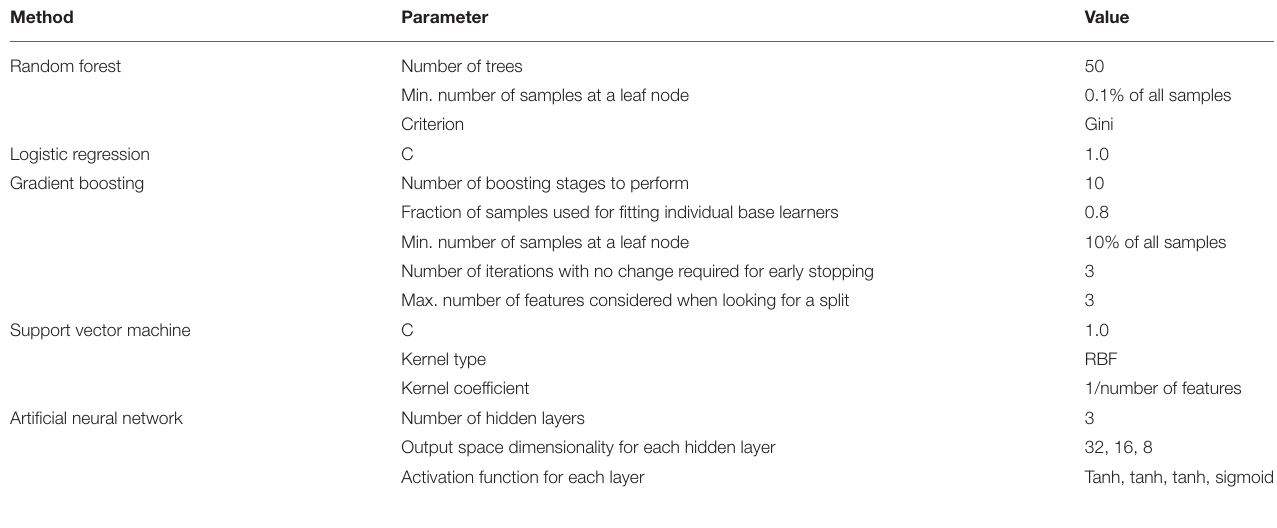
TABLE 1 | Machine learning methods with their parameters.